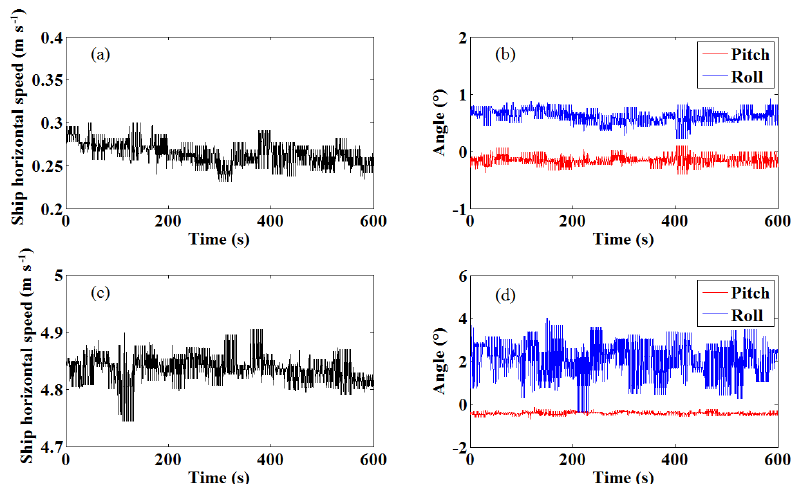
Figure 7. (a) Time series of ship horizontal speed and (b) pitch and roll angles on 9 May 2014 (15:52–16:02) during anchored measurement. (c) Time series of ship horizontal speed and (d) pitch and roll angles on 13 May 2014 (07:44–07:54) during cruising measurement.